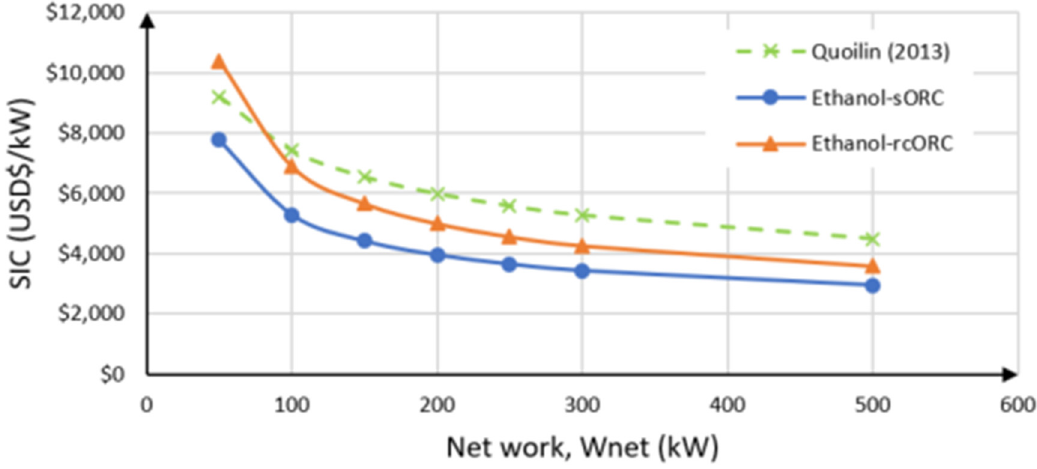
Figure 16. Specific investment cost against net work.